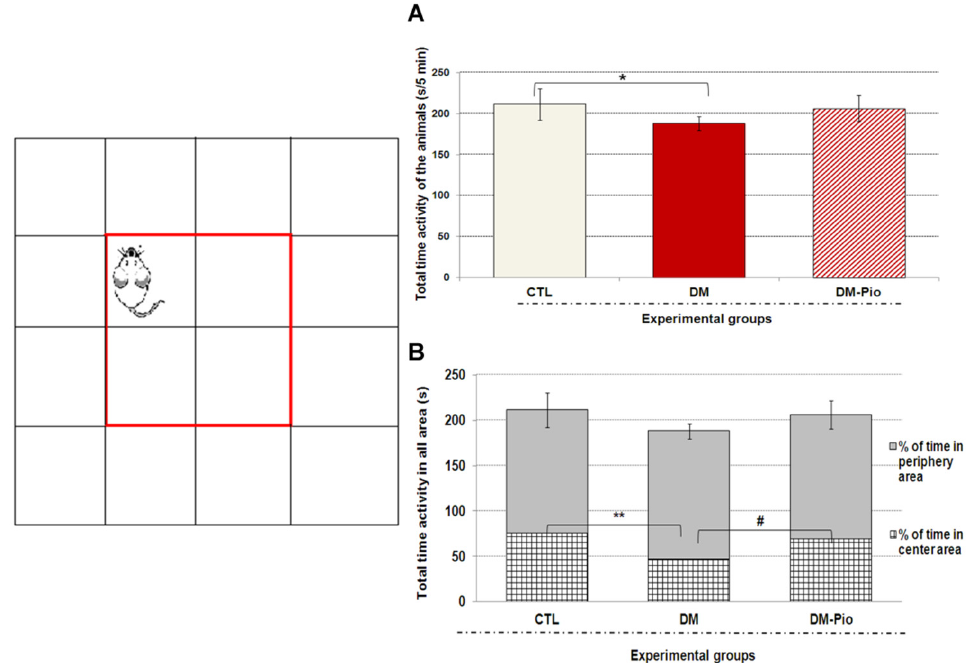
Figure 1. Effect of pioglitazone on exploratory activity in mice with neuroinflammation linked to diabetes ( A , B ). The bar height represents the mean ± SD for individual experimental groups: CTL: non-diabetic mice, DM: diabetic mice, DM-Pio: pioglitazone-treated mice [30 mg/kg, po ]. One-way ANOVA, followed by Tukey’s post hoc test was used. * p < 0.05; ** p < 0.01 in comparison with control group. # p < 0.05 in comparison with diabetes group.